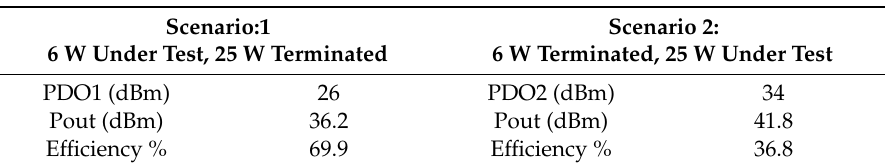
Figure 9. The amplification block stage setup.